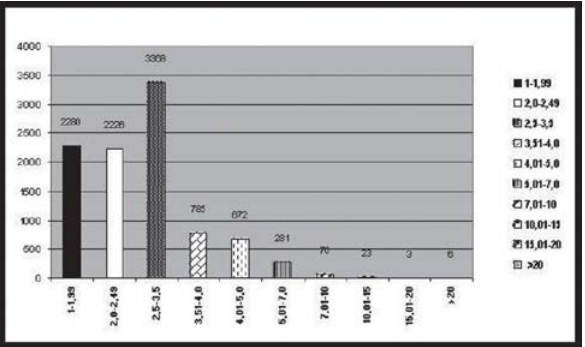
Fig. 1 - Número de consultas de acordo com o intervalo da RNI; eixo das ordenadas: intervalos do tempo de protrombina em RNI; eixo das abscissas: número de consultas